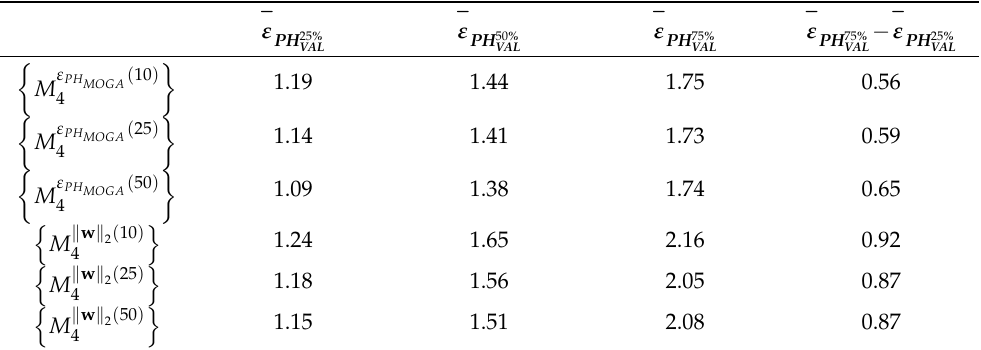
Table 9. Forecasting performances for M 4 .